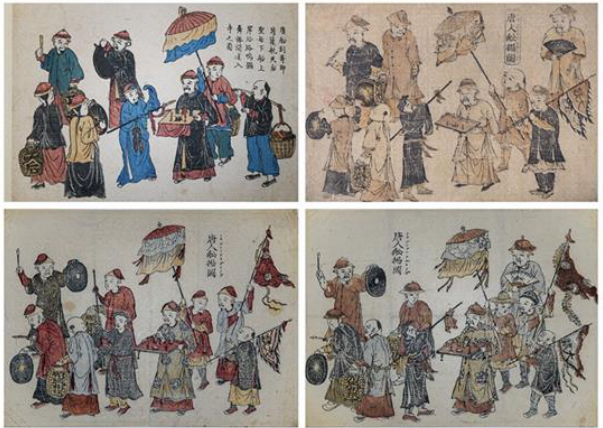
Figure 11. The painting of a Chinese Boat in the collection of the Kobe Municipal Museum, Japan. Source: The Kobe Municipal Museum, Japan. Source: The Kobe Municipal Museum,